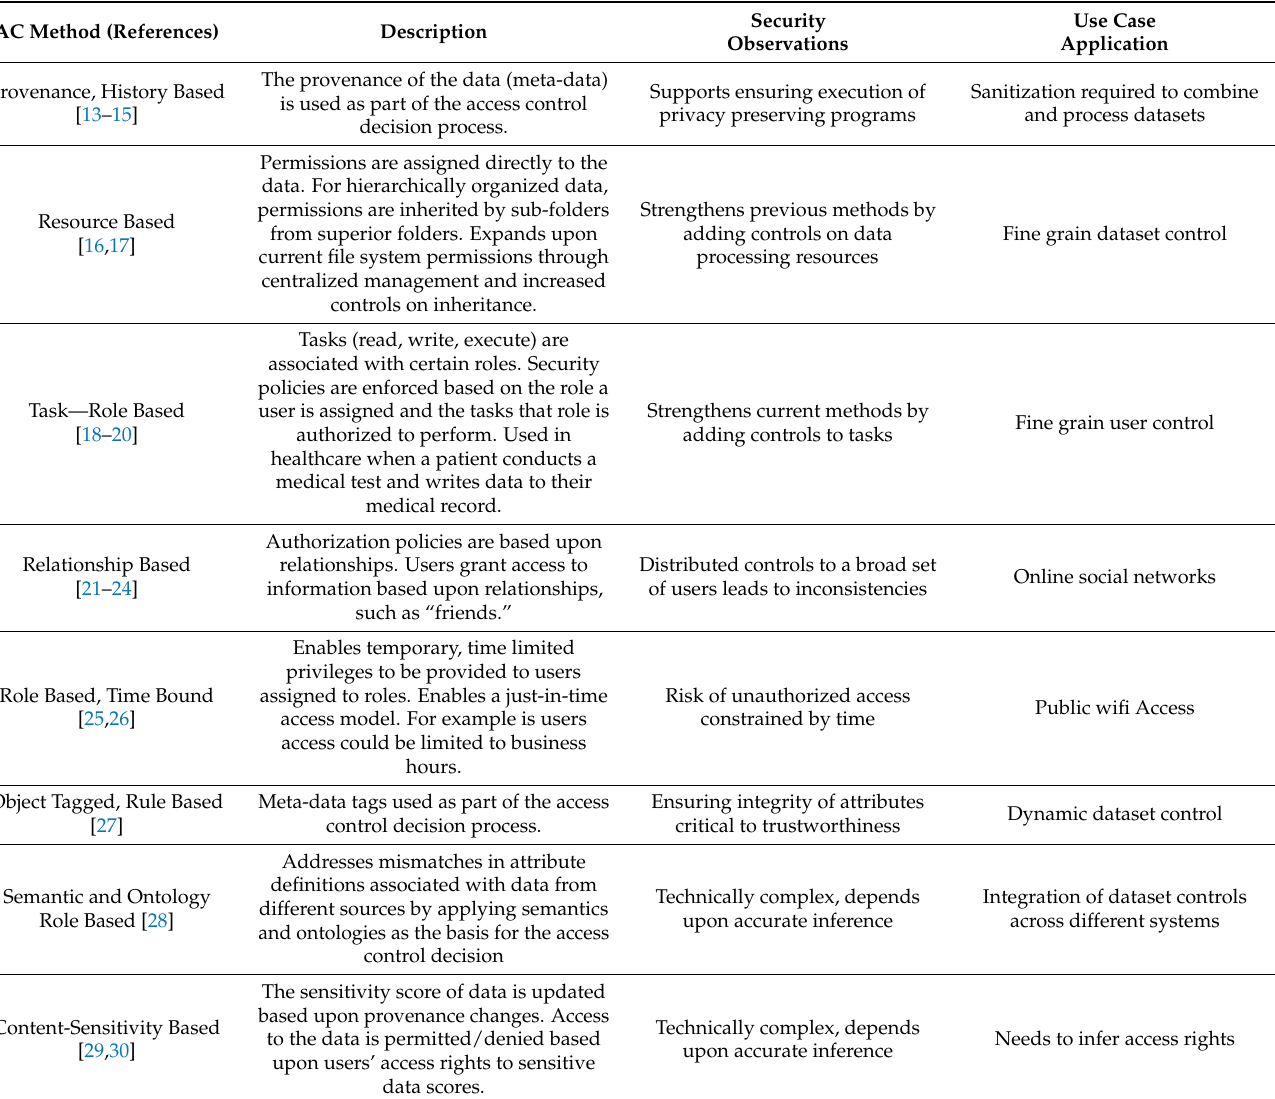
Table 1. Analysis of ABAC approaches in